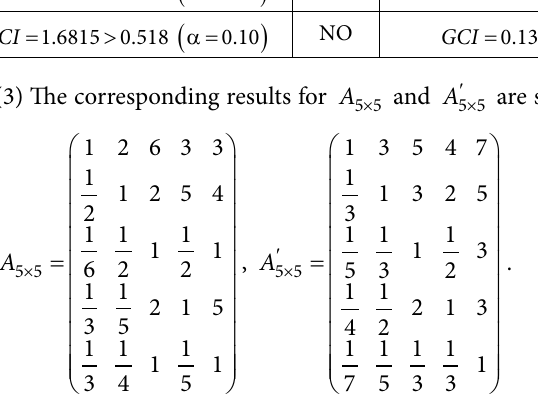
5 Table 6. The corresponding results for two 5-order PCMs × 5 5 A = > 0.1234 0.10 CR NO = < 0.0283 0.10 CR YES = > 0.4305 0.370 GCI > 0.4305 0.380 GCI